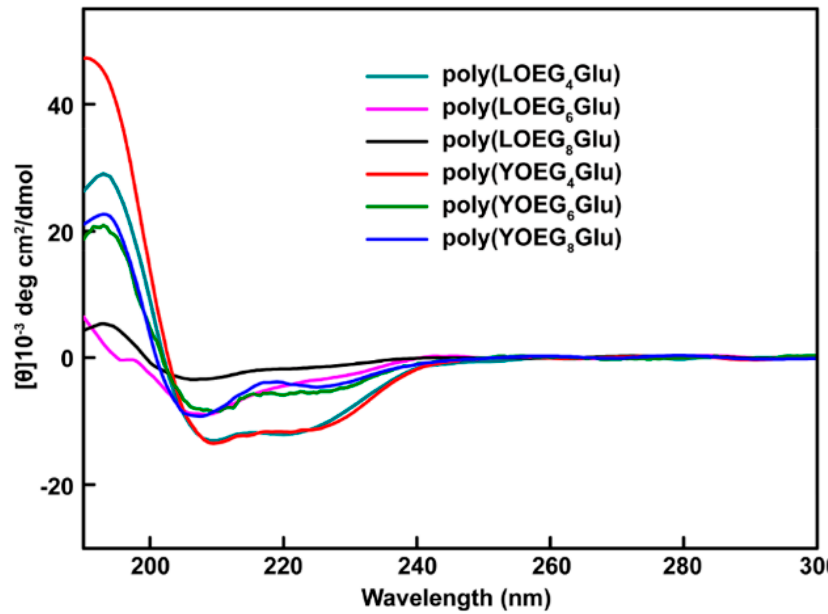
Figure 13. CD spectra of poly(LOEG x Glu)s and poly(YOEG x Glu)s measured in CH 3 CN at 25 °C (c = 0.5 mg/mL). Reproduced with permission [27]. Copyright 2019, American Chemical Society.